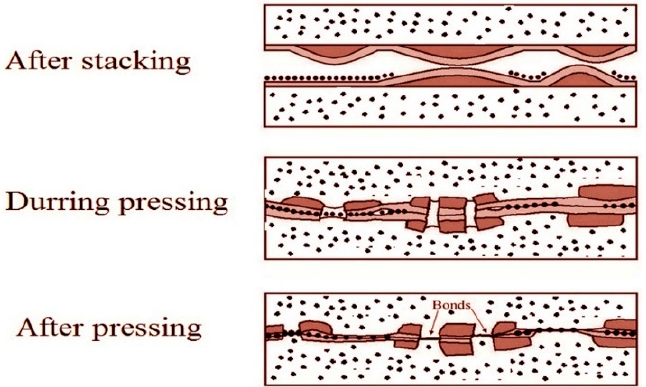
Figure 9. Diagram of the bonding mechanism of stir casted composites. Figure 10 indicates the surface morphology of composite samples after the wear test.